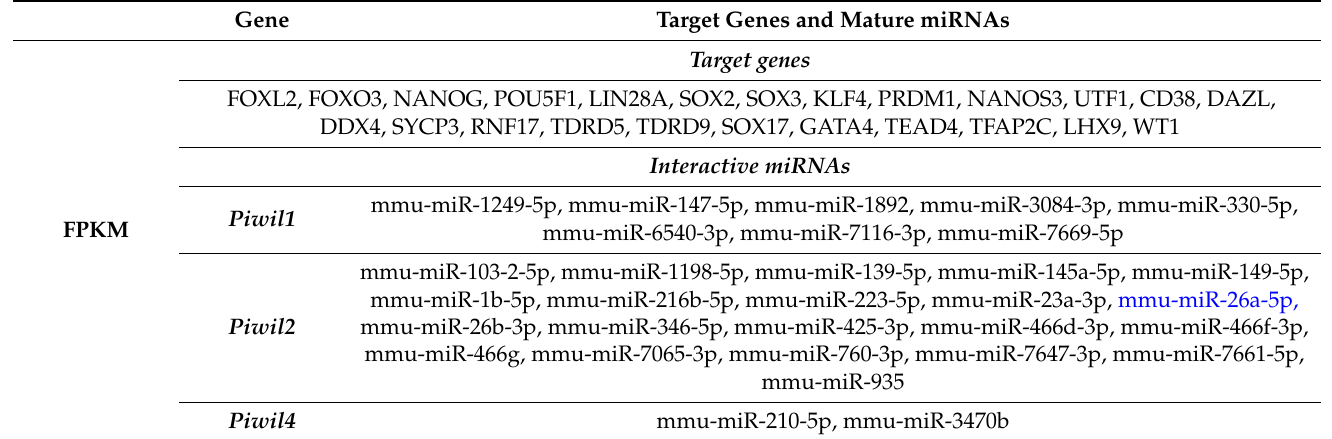
Table 6. Correlation of Piwil gene family expression and frequently expressed target genes and microRNAs in the reproduc- tively aged mouse ovary. Target genes of the Piwil gene family and interactive miRNAs of each Piwil gene were analyzed based on the FPKM correlation ( p < 0.05, score